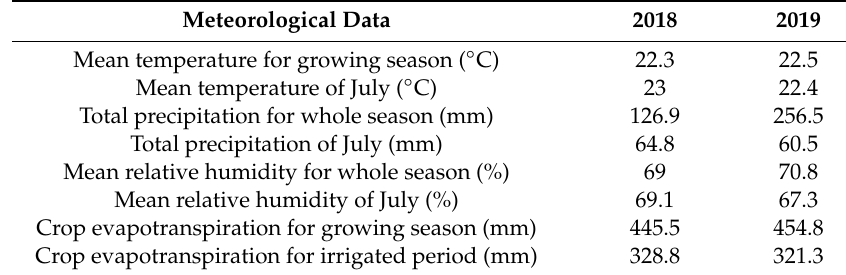
Table 2. Major meteorological data for growing season also focusing on the period of the leaf surface temperature measurements